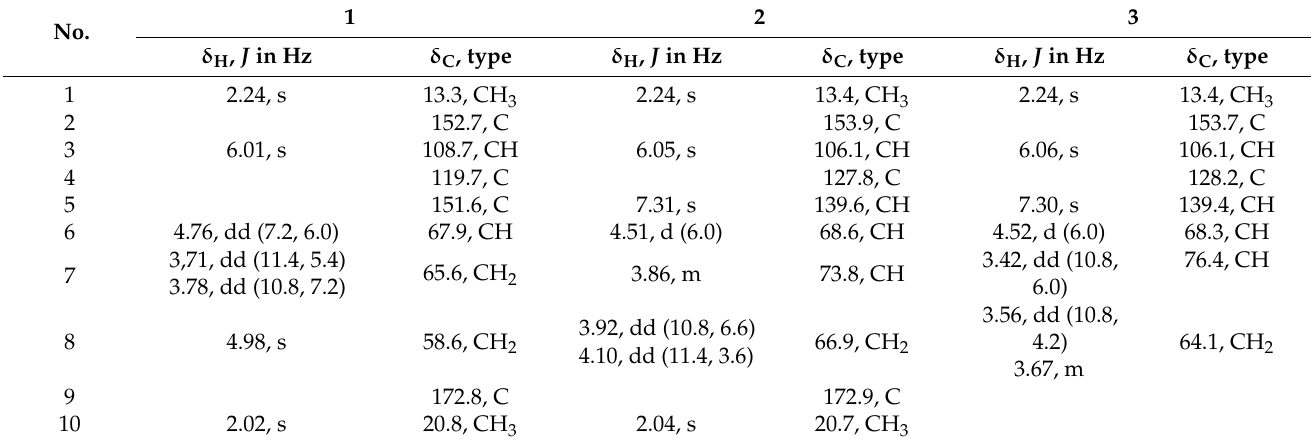
Table 1. 1 H (600 MHz) and 13 C (150 MHz) NMR data for compounds 1 – 3 recorded in Methanol- d 4